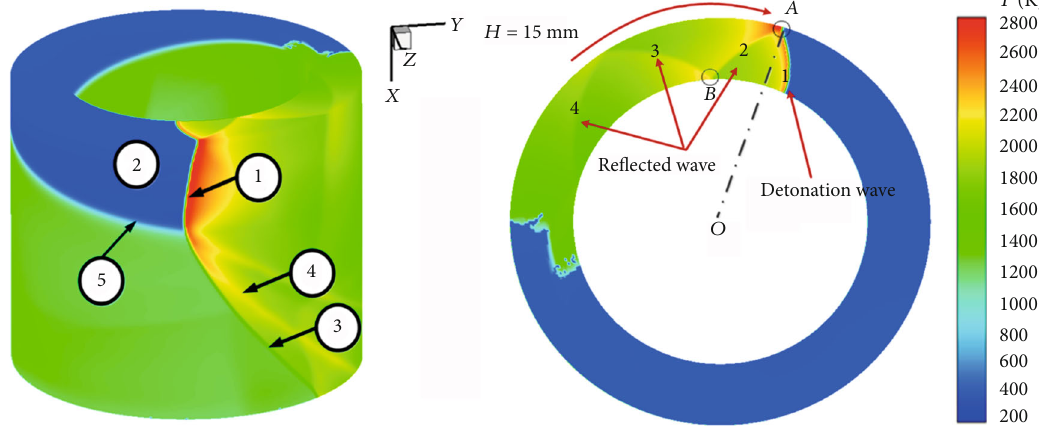
Figure 3: Three-dimensional structure of the continuous rotating detonation wave ( H = 15